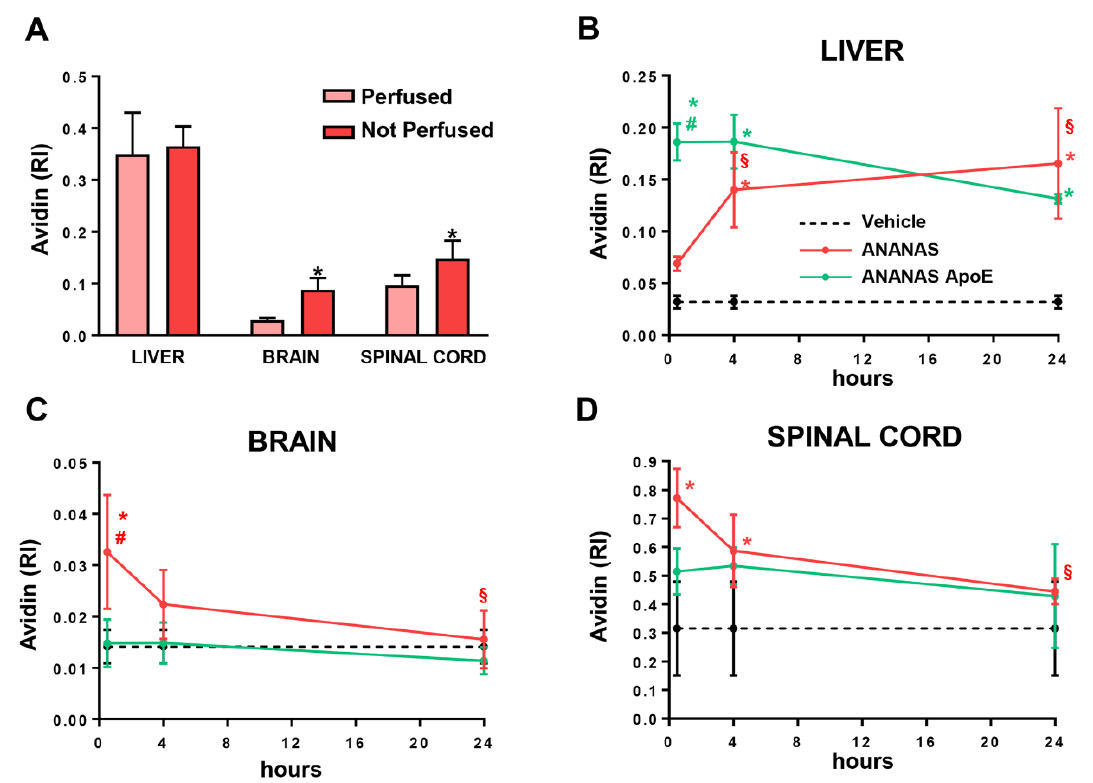
Figure 3. NP biodistribution in WT mice. ( A ) Avidin quantification from liver, brain, and spinal cord of WT mice intravenously treated with ANANAS and sacrificed 30 min after injection, with (pink bars) or (red bars) without intracardial perfusion. Data are mean ± SEM ( n = three in each experimental group) and indicates the relative immunoreactivity (RI) normalized to total protein loading; * p < 0.05 versus the respective perfused tissue by Student’s t -test. ( B – D ) Dot blot analysis for avidin quantification in liver ( B ), brain ( C ), and spinal cord ( D ) of WT mice treated with vehicle (dotted line), ANANAS (red line), and ANANAS-ApoE (green line) and sacrificed with intracardial perfusion 30 min, 4 h, and 24 h after the injection. ( B – D ) Data are mean ± SD ( n = three or four in each experimental group) and indicates the relative immunoreactivity (RI) normalized to total protein loading; * p < 0.05 versus vehicle; # p < 0.05 versus ANANAS-ApoE and § p < 0.05 versus ANANAS 30 min, by one-way ANOVA, Tukey’s post hoc